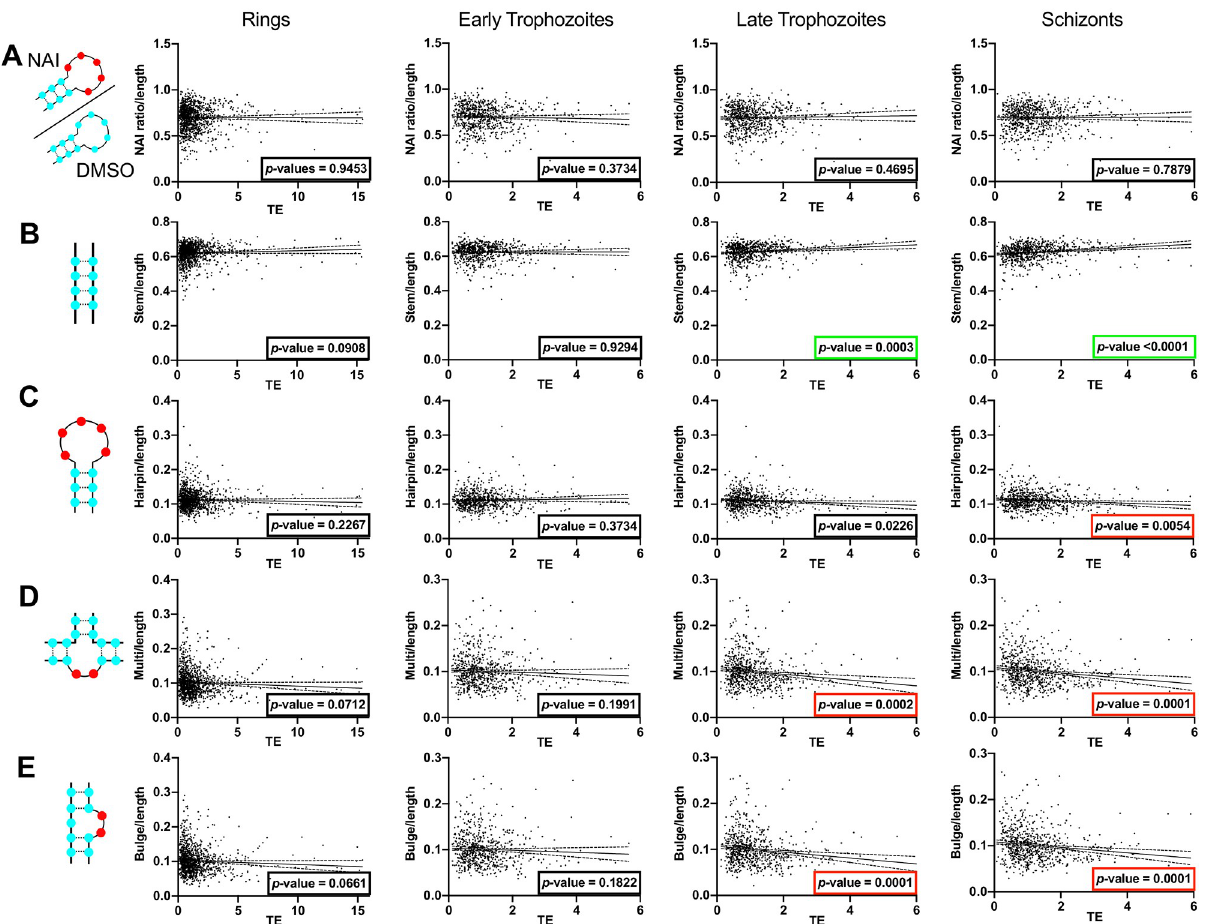
Fig 5. Impact of various RNA motifs on transcription efficiency across the erythrocytic cycle of P . falciparum . The columns represent the different erythrocytic stages of P . falciparum and the rows represent the correlation between transcription efficiency and (A) the transcript structuredness normalised by the transcript length, (B) the number of stems, (C) the number of hairpins, (D) the number of multi-stem loops and (E) the number of bulges. Statistically significant positive correlations have a p -value framed in green and statistically significant negative correlations have a p -value framed in